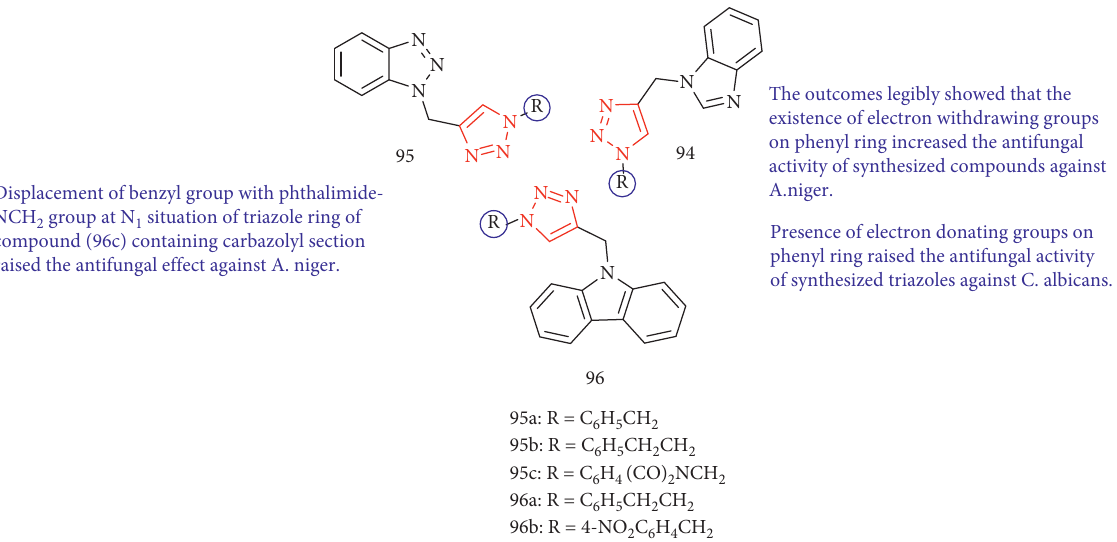
Figure 43: Chemical structure of 1,4-disubstituted 1,2,3-triazoles containing benzo-fused N-heteroaromatic moieties.